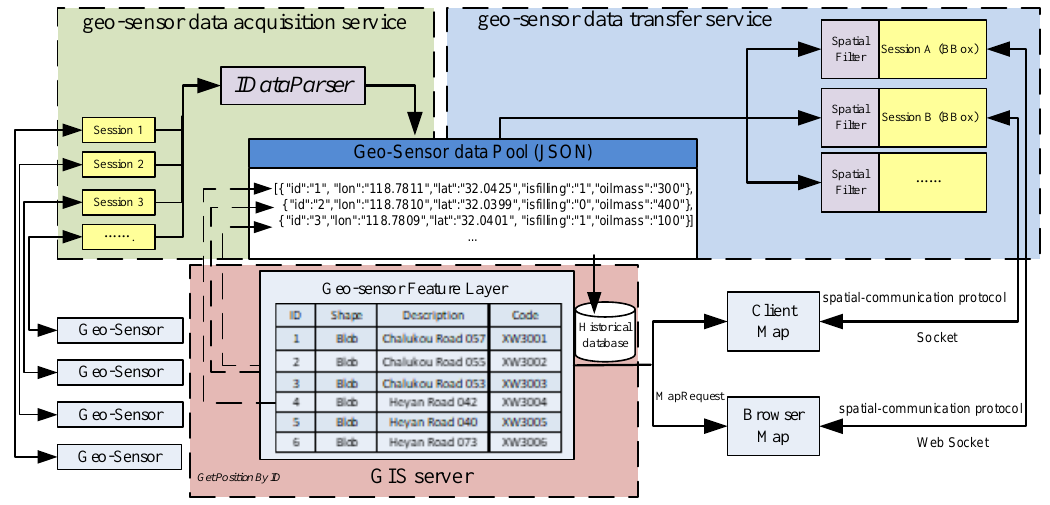
Figure 6. Geo-sensor data acquisition and transfer services in message broker. The spatial-communication protocol was defined in the JSON format as shown in Table 1.